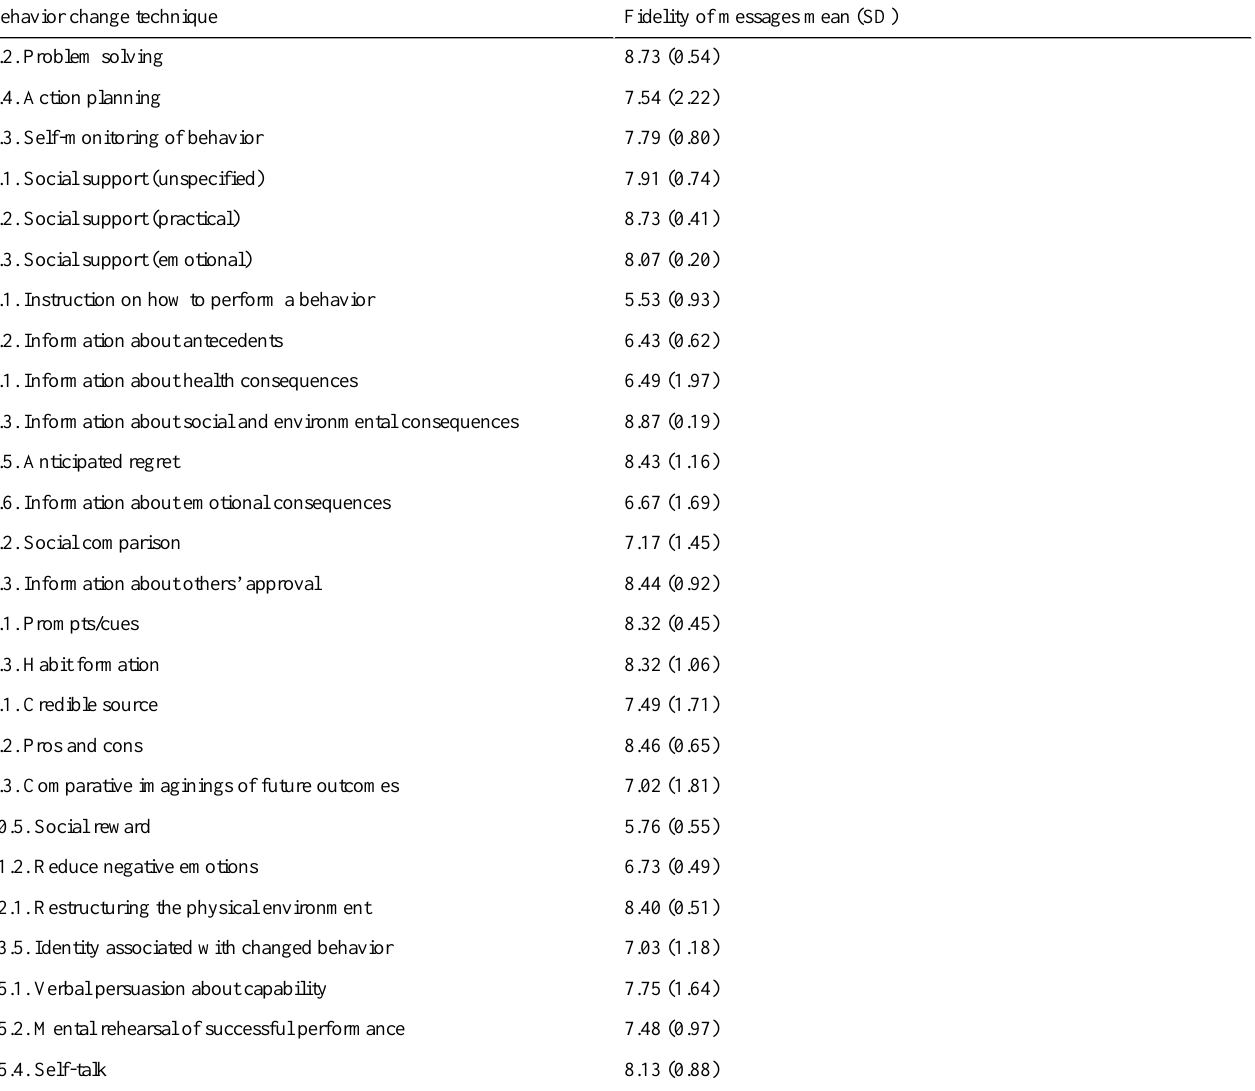
Table 5. Fidelity of the messages to the intended behavior change techniques from study